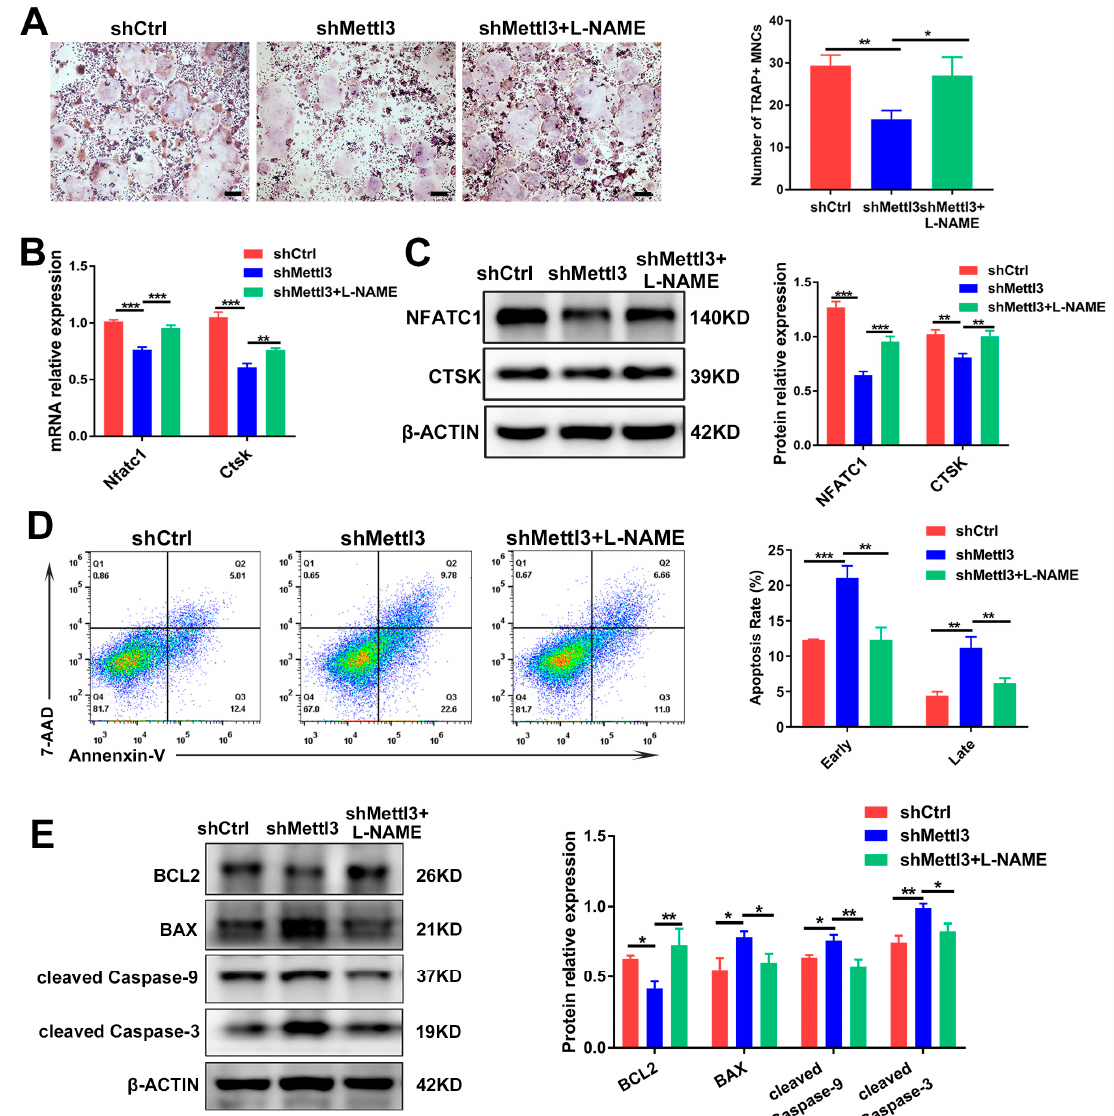
Figure 5. The rescuing effect of L-NAME on osteoclast differentiation and apoptosis in METTL3- silenced cells treated with LPS. Osteoclast precursors transfected with shRNA and pretreated with RANKL were differentiated into osteoclasts by LPS (200 ng/mL) induction in the absence or presence of L-NAME (500 μ M). ( A ) Images of TRAP staining. Scale bars, 200 μ m. The mRNA and protein levels of NFATC1 and CTSK were assessed using qRT-PCR ( B ) and Western blotting ( C ). ( D ) The apoptosis rate of osteoclasts was determined by flow cytometry analysis. ( E ) The protein levels of BCL2, BAX, cleaved caspase-9 and cleaved caspase-3 were evaluated using Western blotting. β -Actin was used as an internal control for qRT-PCR and Western blotting. The data are shown as the mean ± SD ( n = 3). * p < 0.05; ** p < 0.01; *** p < 0.001.